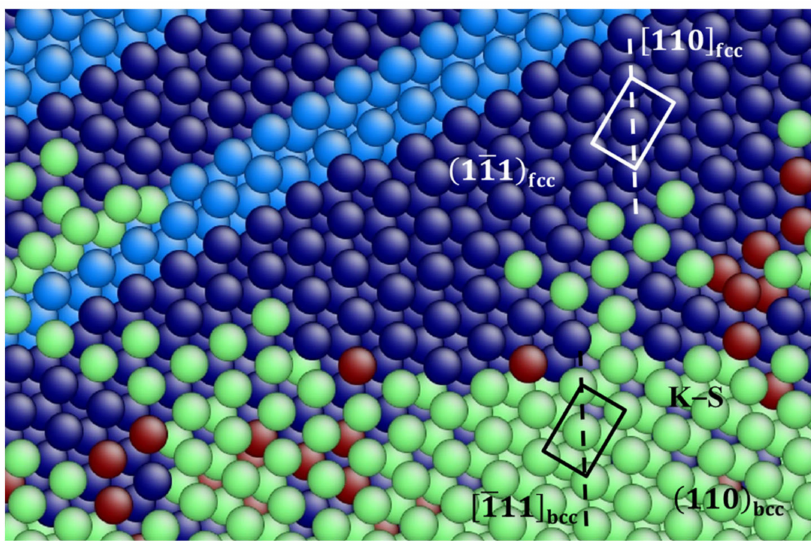
Figure 9. A zoomed snapshot of the ongoing martensitic phase transition in film 2 at 300 K. The colors denote the local crystal structure as in Figure 5. The black rectangle indicates a bcc unit cell on the (110 bcc plane and the white rectangle shows a unit cell of the parent fcc phase on the (111) fcc plane.